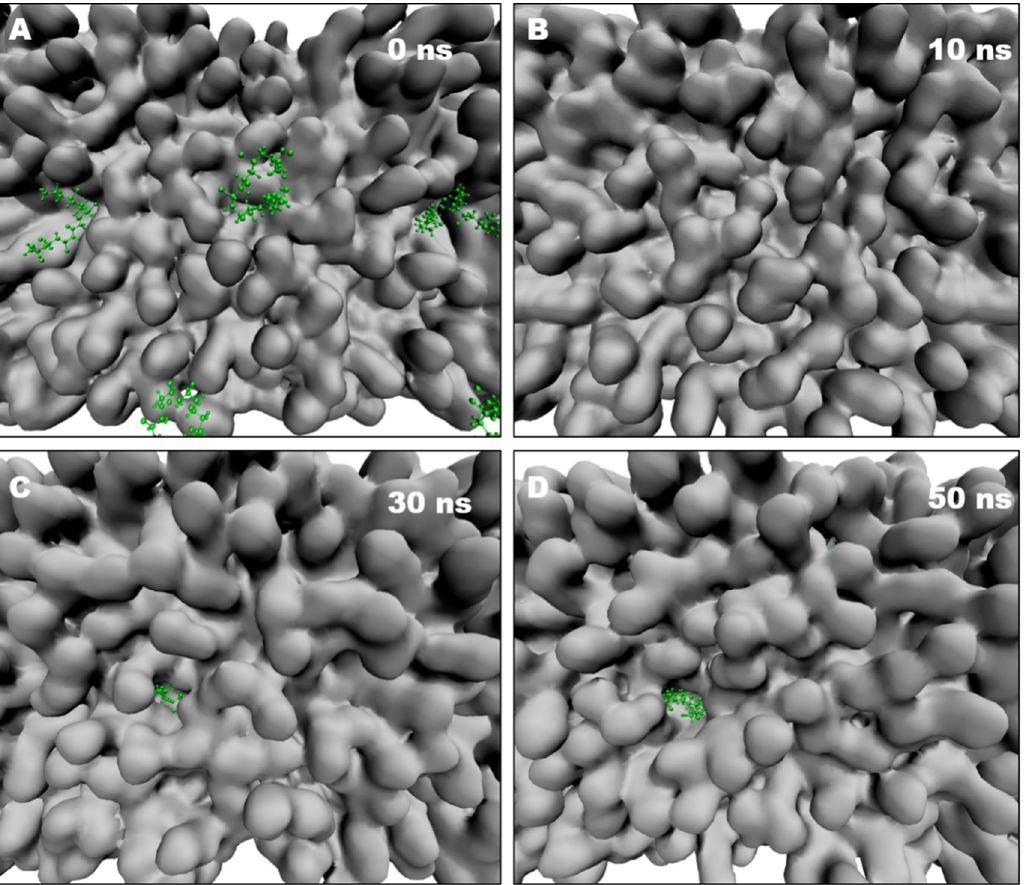
Figure 7. Membrane pore formation is induced by NPs. ( A ) Top view of a lipid bilayer with 10 PVC10 monomers. ( B ) Intact lipid bilayer before pore formation (10 ns from the start of the simulation). ( C ) Pore formation in the hydrophobic lipid tails induced by NPs (starting from the intact lipid bilayer shown in A, at 30 ns). ( D ) Expansion to a larger pore (~1 nm in diameter) with lipids around the pore (at 50 ns). The lipids composition is in silver and the PVC10 molecules are in green.